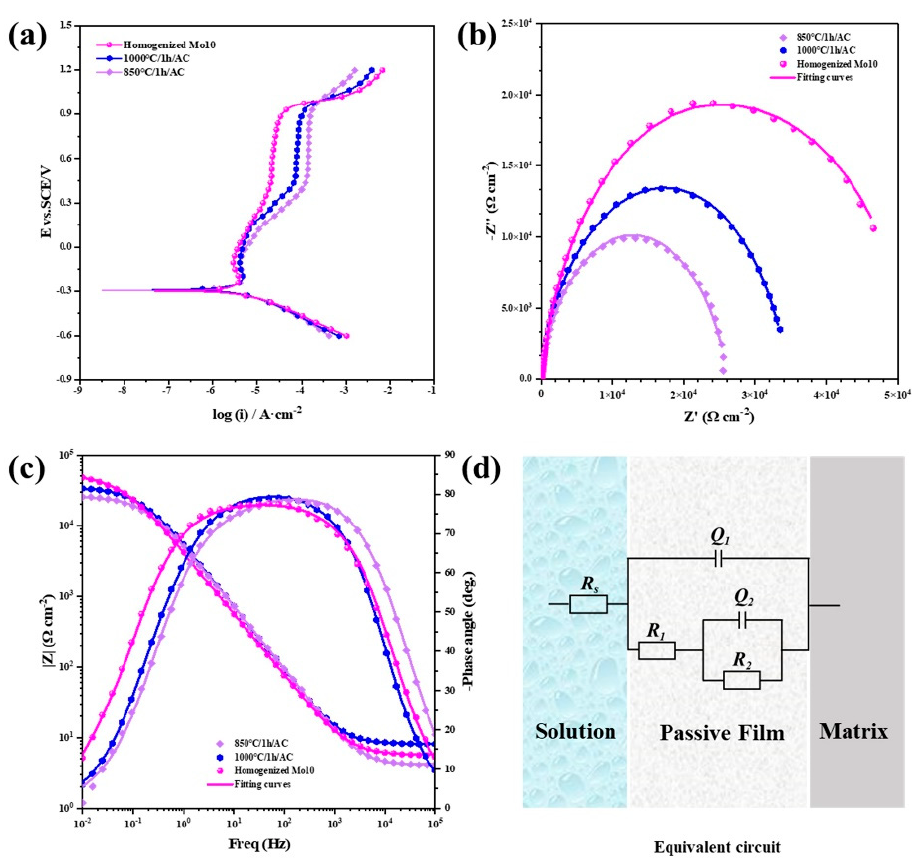
Figure 7. Electrochemical testing of the Mo 10 HEA: ( a ) potentiodynamic polarization curves of the 850 °C − annealed sample, the 1000 °C − annealed sample, and homogenized Mo 10 sample in 0.5 M H 2 SO 4 solution; ( b ) Nyquist curves; ( c ) Bode curves; ( d ) equivalent circuit. Table 3. The electrochemical testing results obtained from Figure